Question: Based on the figure, does the quantity rise or fall?
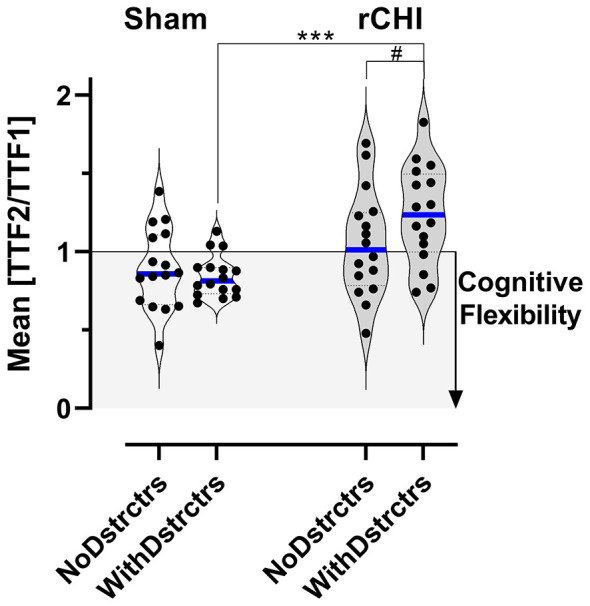
Answer: increasing